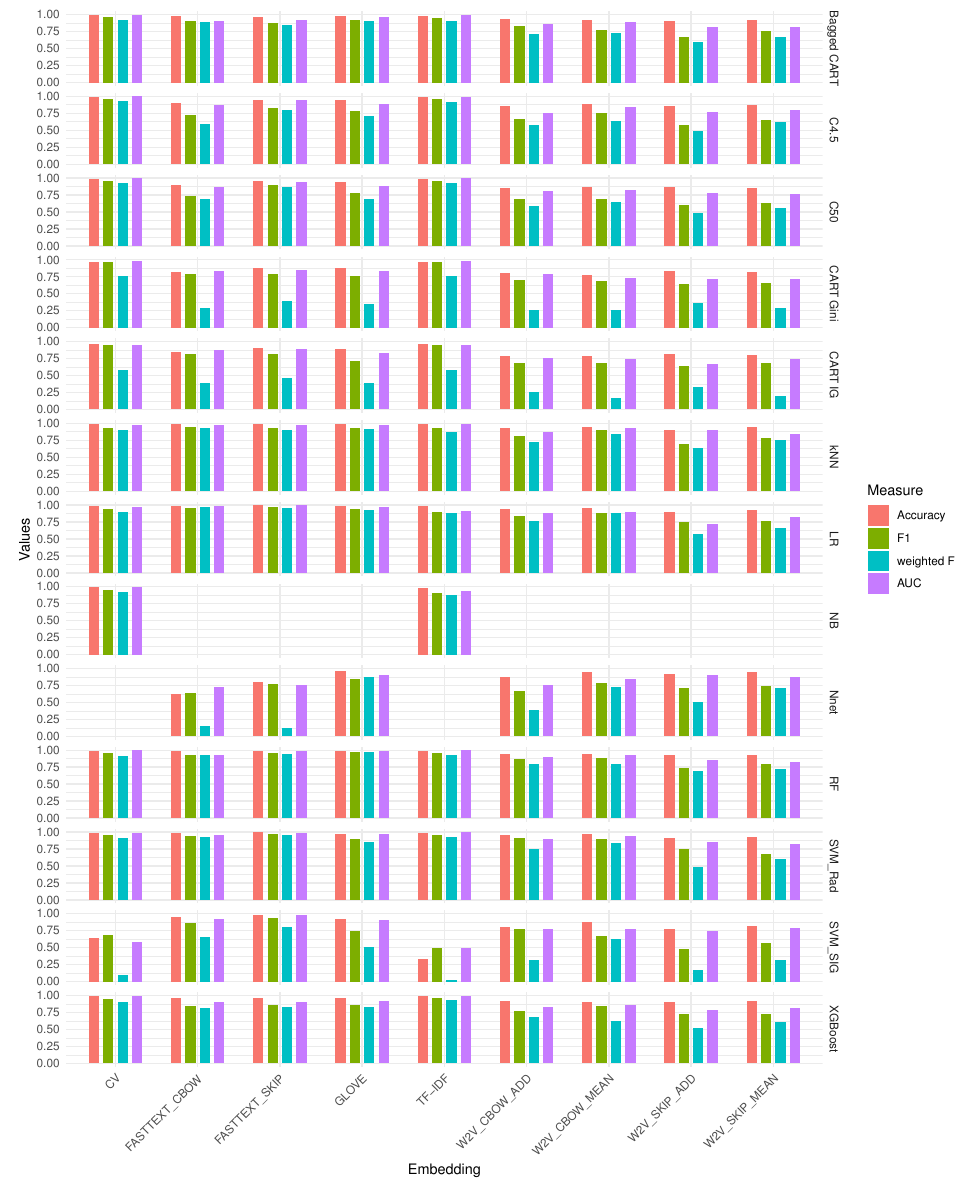
Figure 5. Performance metrics for automatic classification